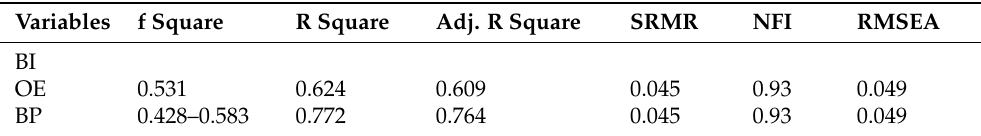
Table 5. Model fit